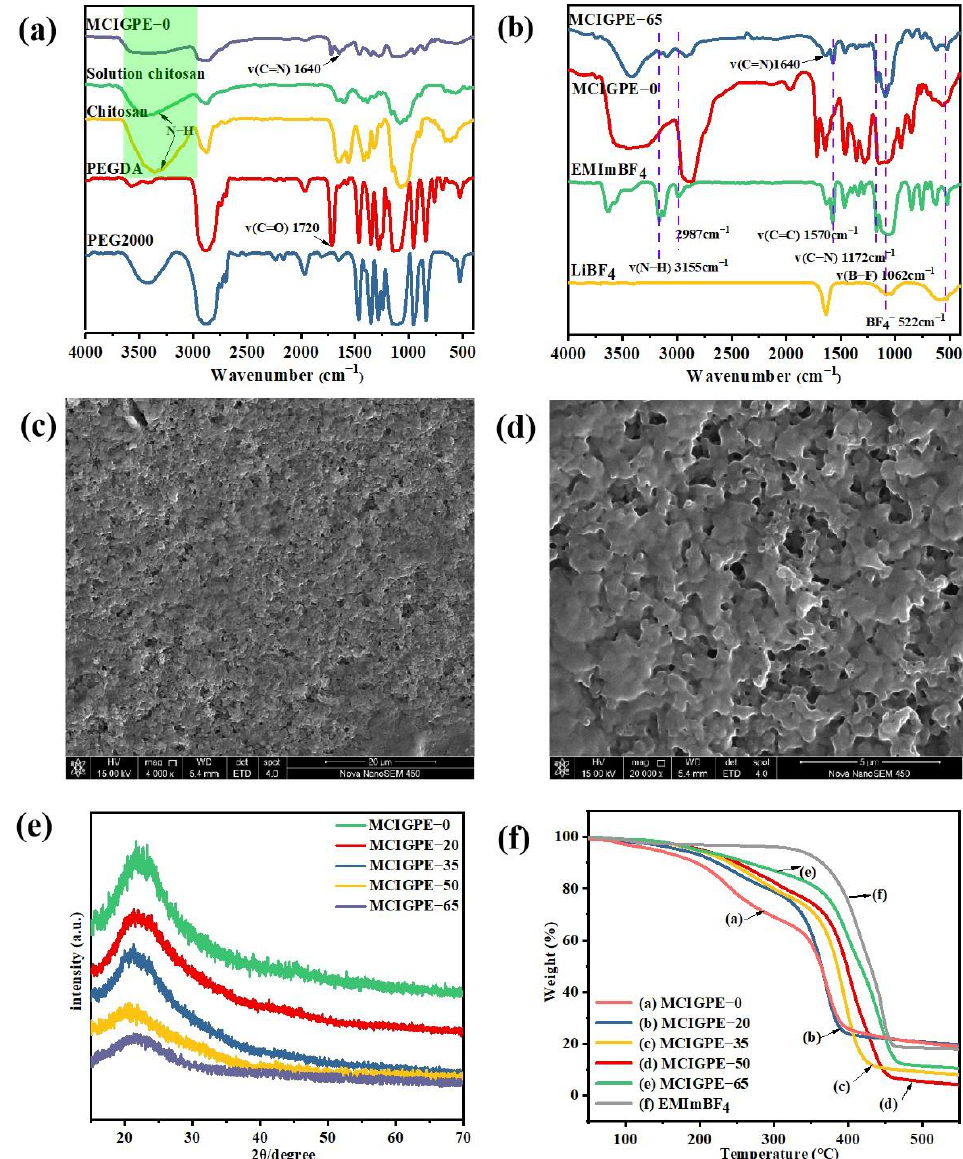
Figure 2. ( a ) FT − IR spectrum of PEG2000, PEGDA, solution chitosan, chitosan and MCIGPE − 0; ( b ) LiBF 4 , EMImBF 4, MCIGPE − 0 and MCIGPE − 65 in the range of 4000~400 cm − 1 ; SEM of MCIGPE − 0 at ( c ) 20 µ m and ( d ) 5 µ m magnifications; ( e ) X − ray diffraction (XRD) of MCIGPEs contain different IL; ( f ) TGA curves of MCIGPE with different ionic liquids in a nitrogen atmosphere. The TGA curves of EMImBF 4 , MCIGPE − 0, MCIGPE − 20, MCIGPE − 35, MCIGPE − 50,